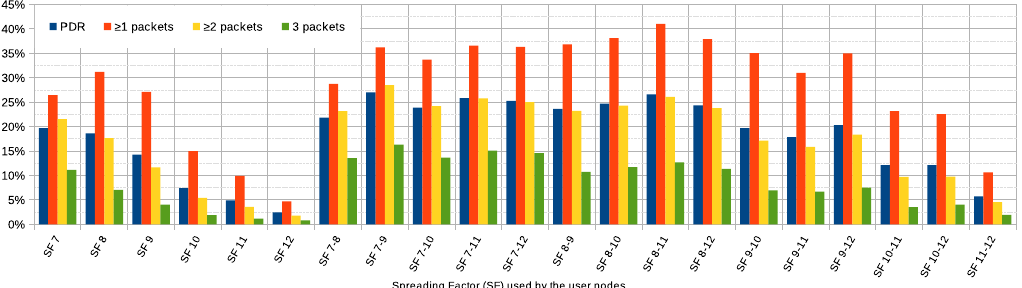
Figure 7. PDR and ratio of user nodes successfully transmitting ≥ 1, ≥ 2 and 3 packets, in a function of the chosen